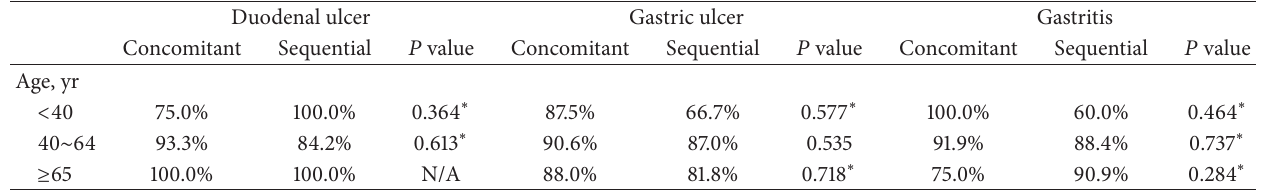
Table 6: Comparison of eradication rates among duodenal ulcer, gastric ulcer, and gastritis in each age